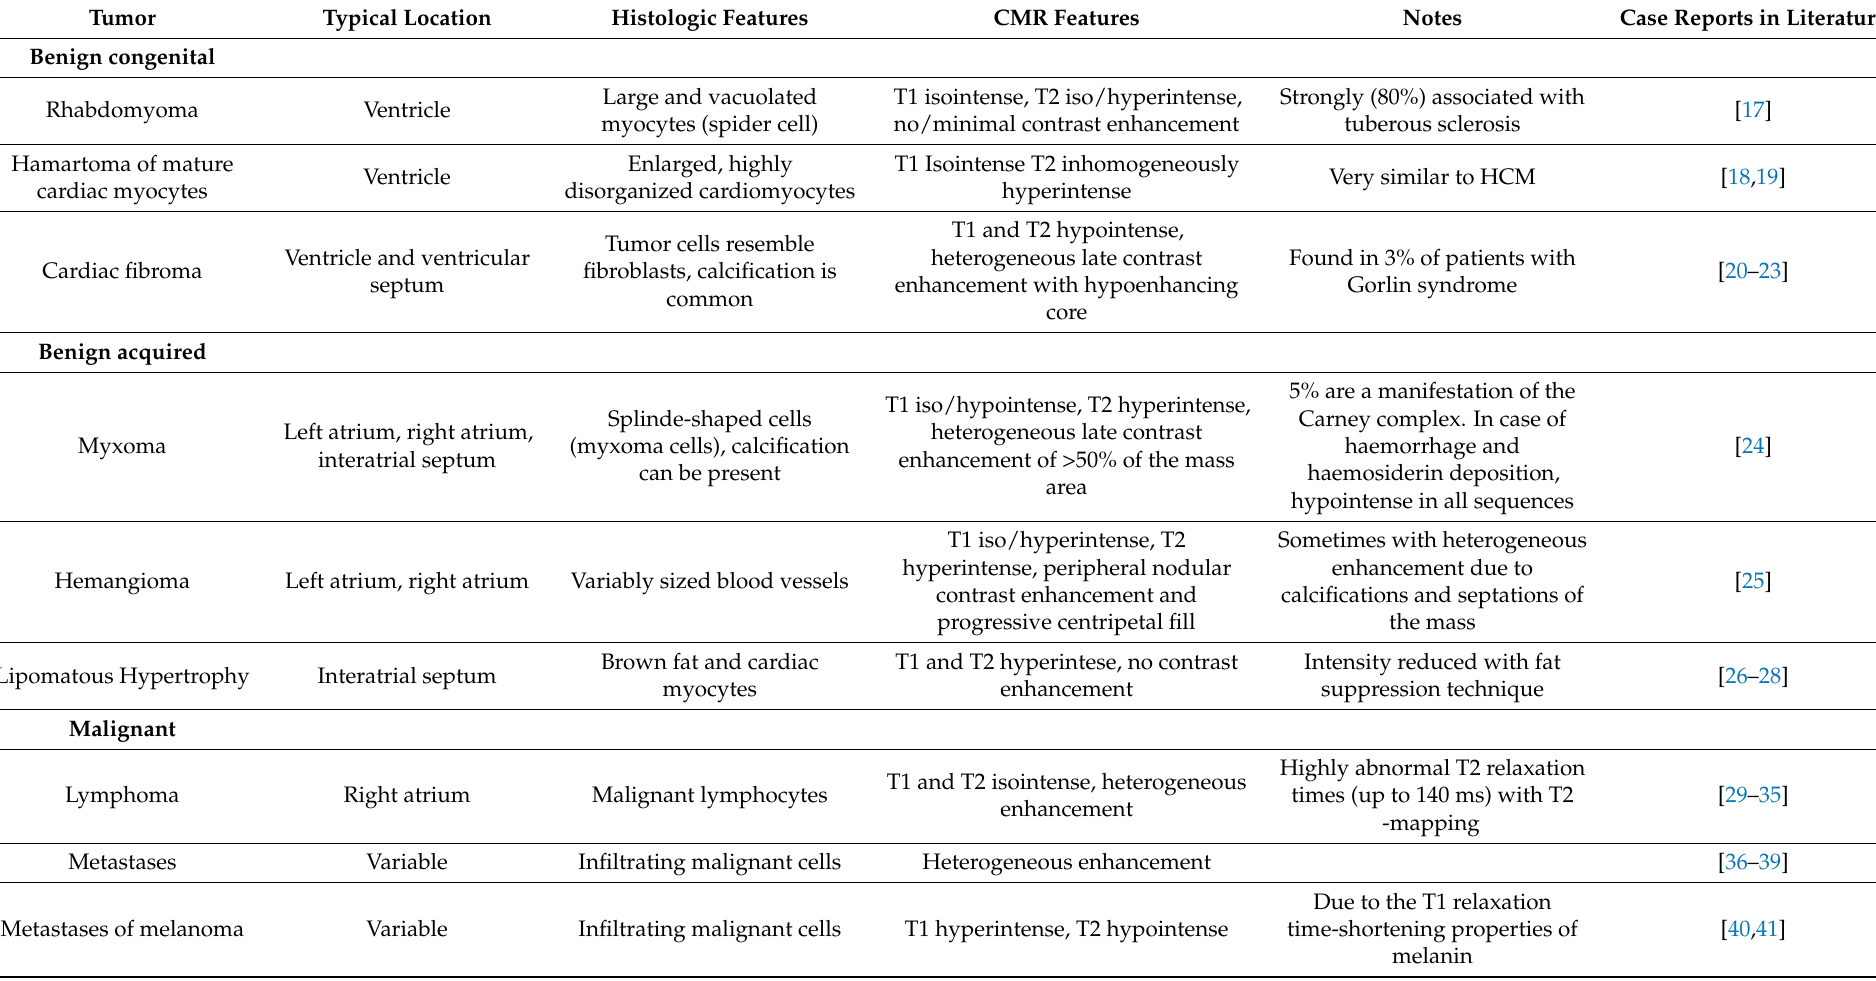
Table 2. Case reports of tumoral phenocopies and main features of cardiac